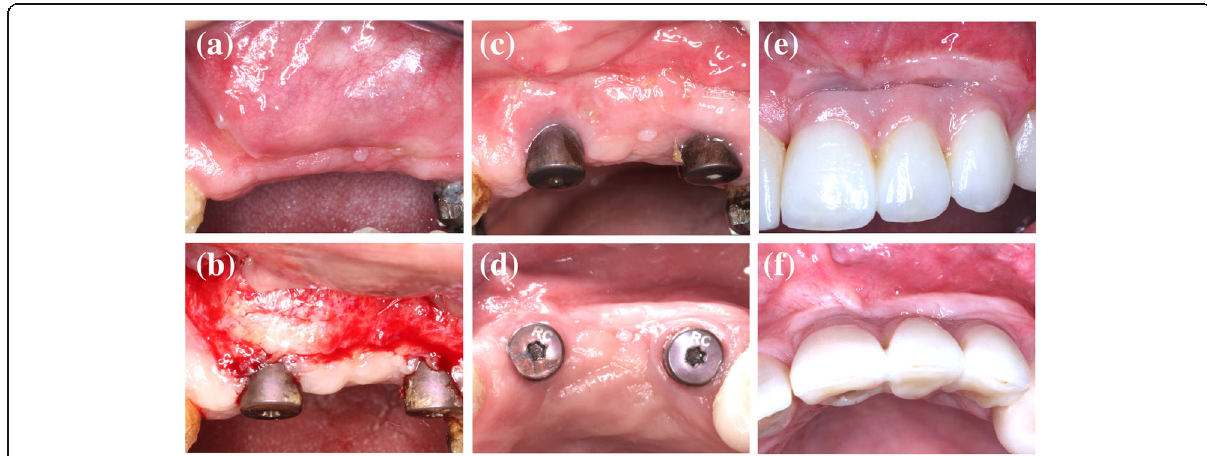
Fig. 7 Second stage surgery of patient in Fig. 1. a Vestibular depth reduction after augmentation and implant placement. b Partial thickness and apical repositioned flap. c CMX healing and soft tissue dehiscence with CCXBB exposure. d Dehiscence healing after re-contouring and buccal emergency profile. e Buccal aspect of the final restoration. f Buccal ridge contour